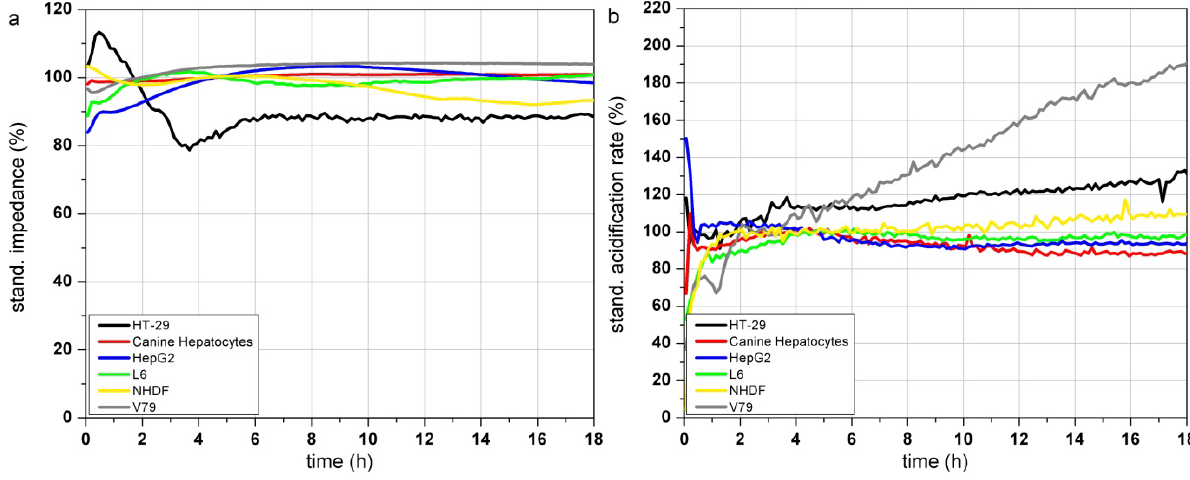
Figure 3. Time course of impedance ( a ), acidification ( b ) and respiration ( c ) of different eukaryotic cell types during 18 h incubation in the Bionas 2500 Analyzing System: human colon carcinoma cell line HT-29 (black), Canine hepatocytes (red), hepatocellular carcinoma cell line HepG2 (blue), rat skeletal muscle cell line L6 (green), normal human dermal fibroblasts NHDF (yellow) and Chinese hamster lung fibroblasts V79 cells